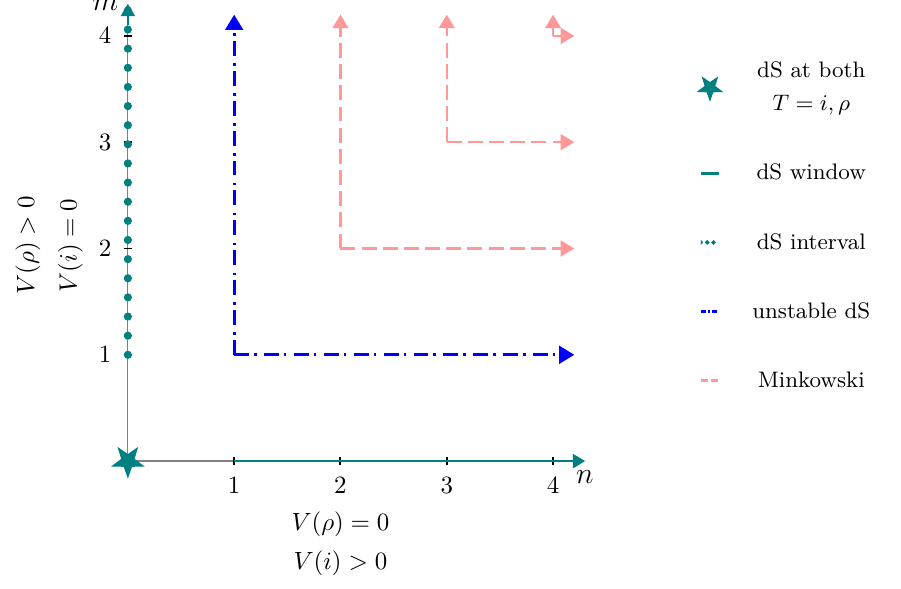
Figure 2 . Summary of dS vacua possibilities at the fixed points with respect to the integers ( m, n ) in H ( T ) assuming the dilaton is stabilized. At (0 , 0) , both fixed points can have a dS vacuum. For ( m, 0) , T = ρ is a dS minimum if A ( S, ¯ S ) > 3 . For (0 , n ) , T = i can be a dS vacuum for a window of A ( S, ¯ S ) values that increases with n and is dependent on P ( j ( T )) . The cases (1 , n ) or ( m, 1) result in unstable dS extrema. Finally, we always have Minkowski extrema at the self dual